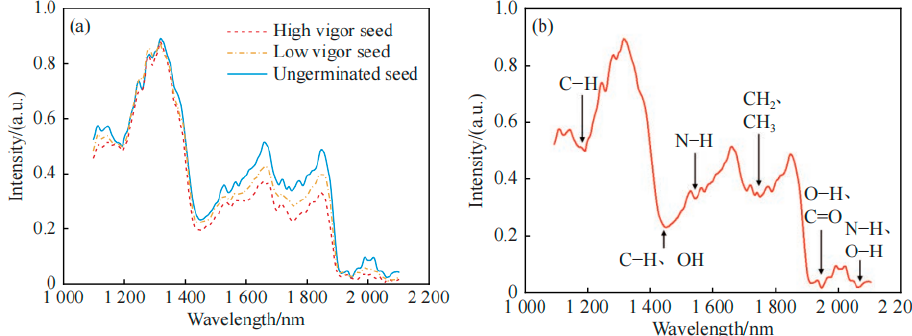
Figure 1. Near-infrared absorption spectrum of rice seeds; ( a ) The average curves of transmission spectra of rice seeds with different vigor characteristics; ( b ) Near-infrared absorption spectrum of high vigor seeds.